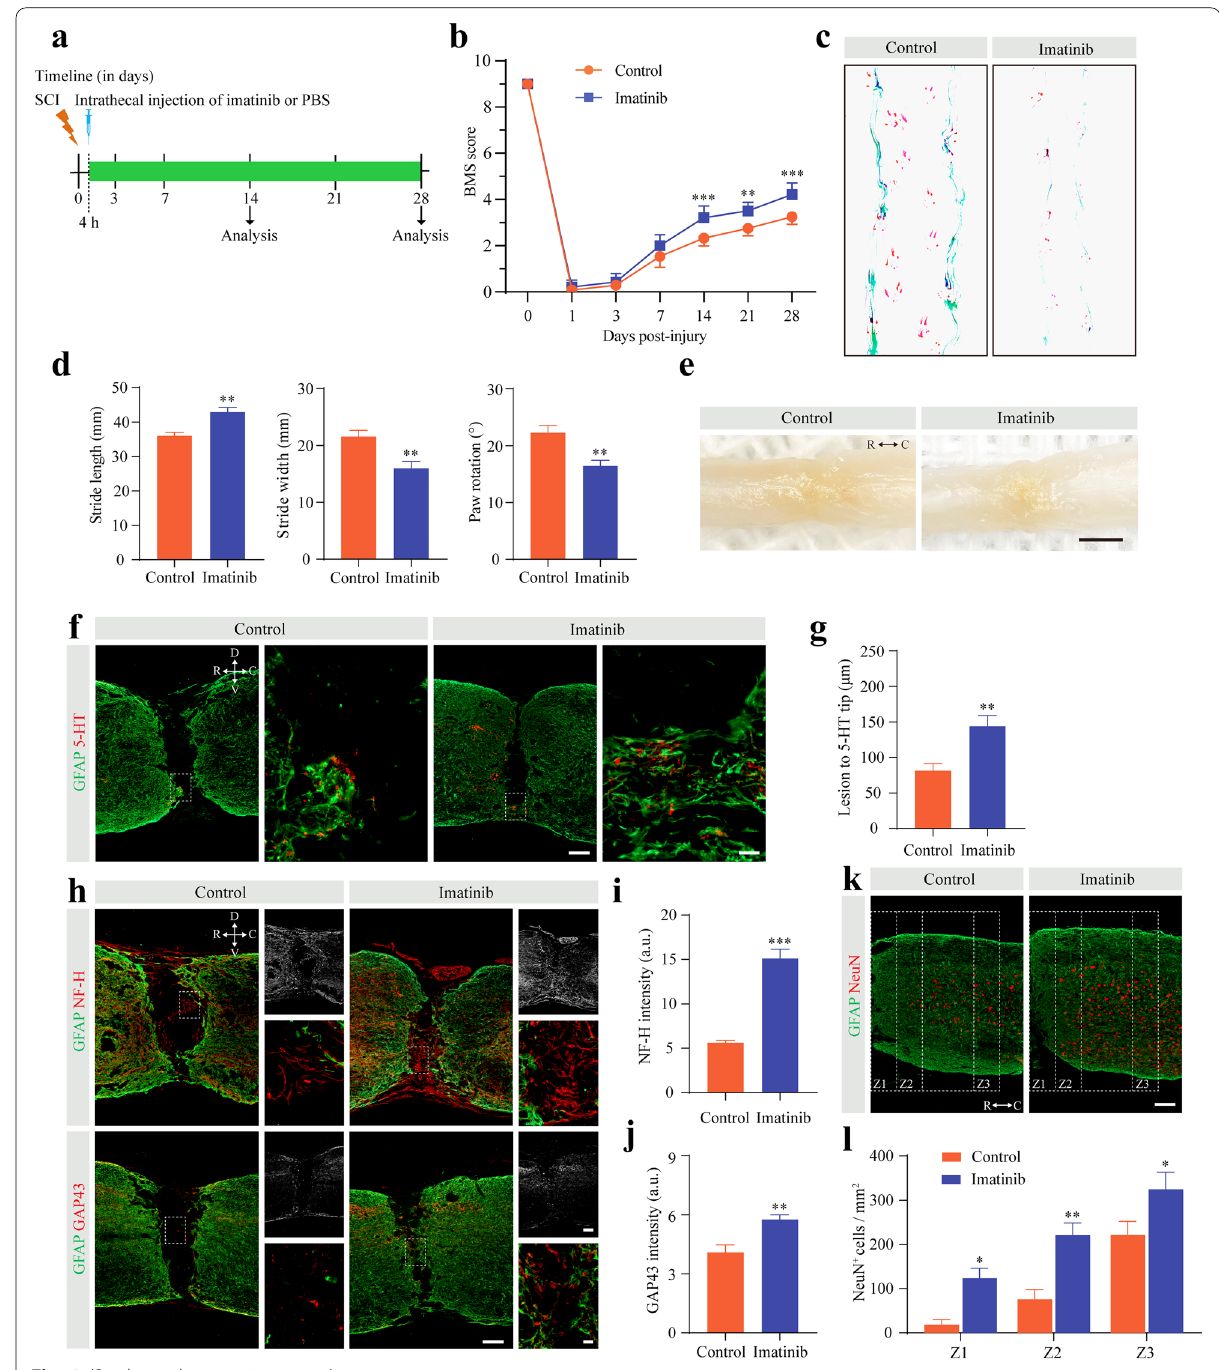
Fig. 6 (See legend on previous